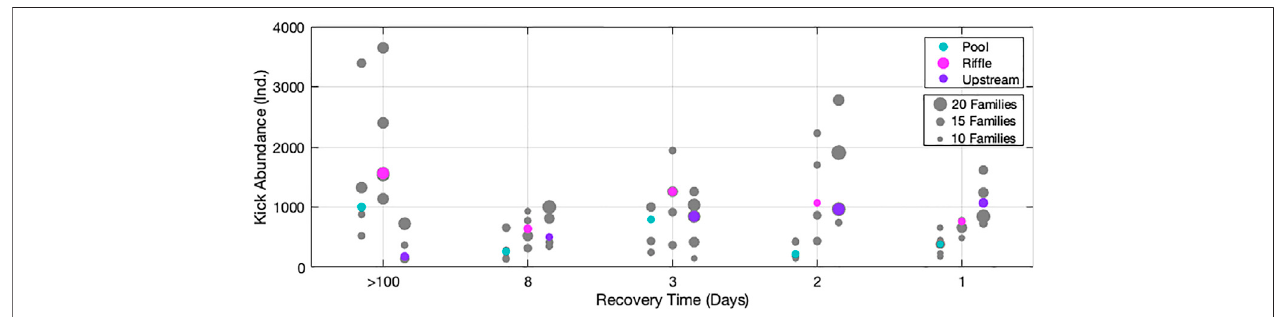
FIGURE 6 | Habitat-speci fi c kick sample abundances. The x -axis shows recovery time with fi ve replicates per experimental peak from the upstream, and two downstream habitats (rif fl e and pool); y -axis shows total abundance. The dots are proportional to the number of families in the sample. The dots also include taxa Turbellaria, Collembola, and Hydracarina though they were only identi fi ed to order level. The colored dots indicate the median samples for each habitat.